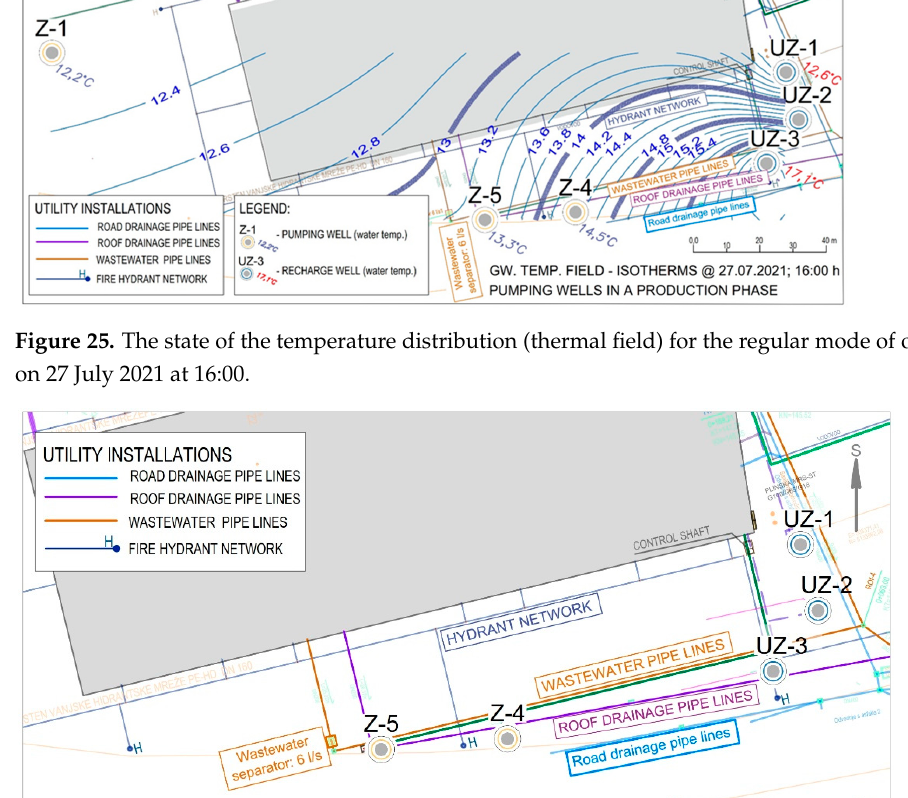
Figure 25. The state of the temperature distribution (thermal field) for the regular mode of operation on 27 July 2021 at 16:00.